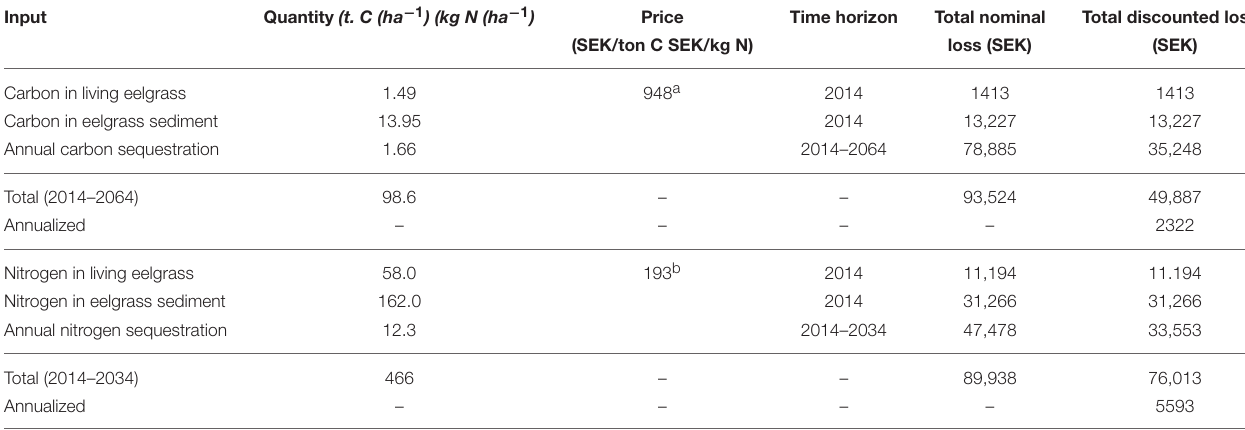
TABLE 5 | Estimating per hectare value of eelgrass—Carbon and Nitrogen storage. Input